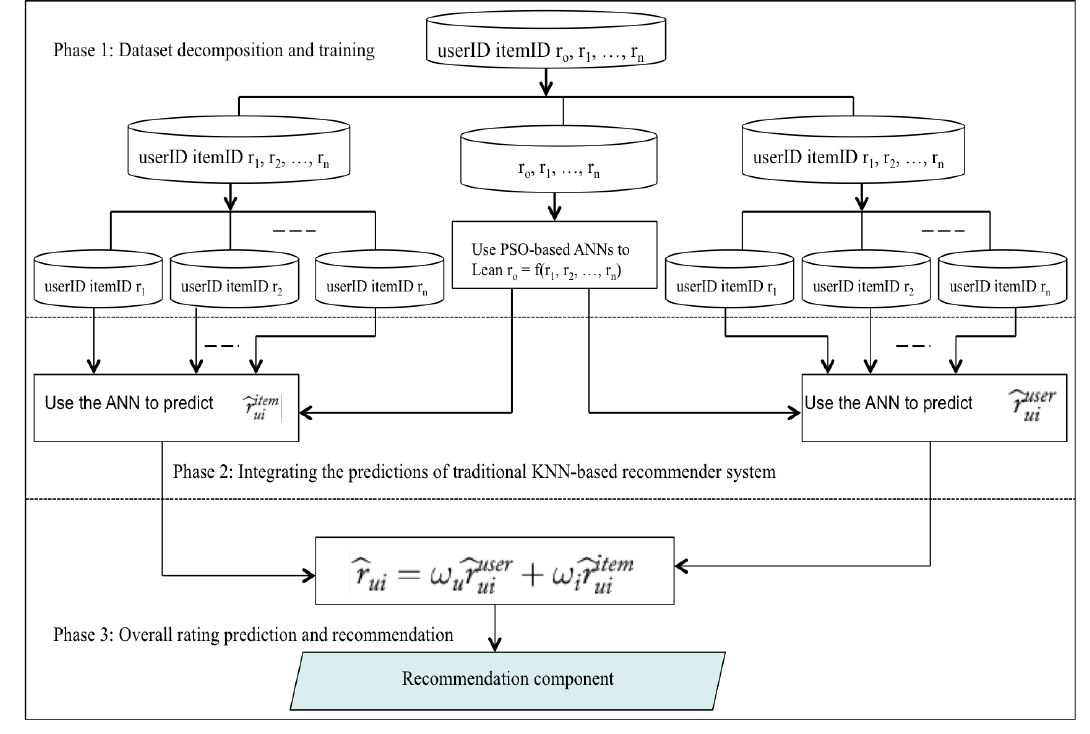
Figure 3. Framework of the proposed ANN -based MCRSs